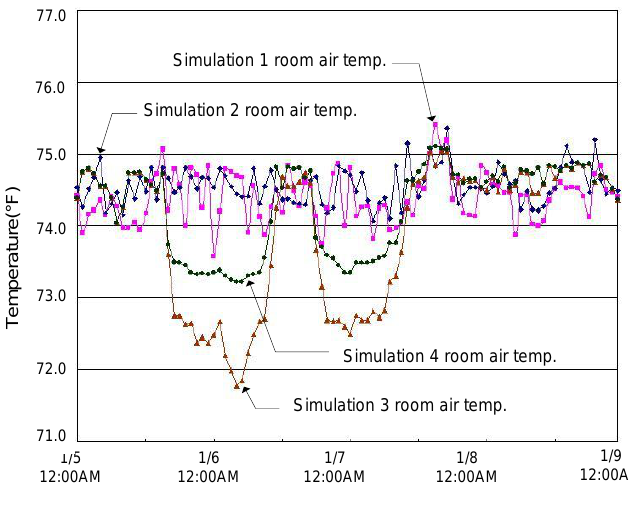
Figure 2. Simulation results of north zone air